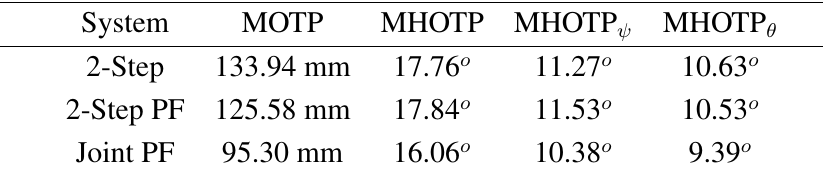
Table 1. Tracking performance joint and two-step approaches for an A-MOTA working point of 10%. PF, particle filter.